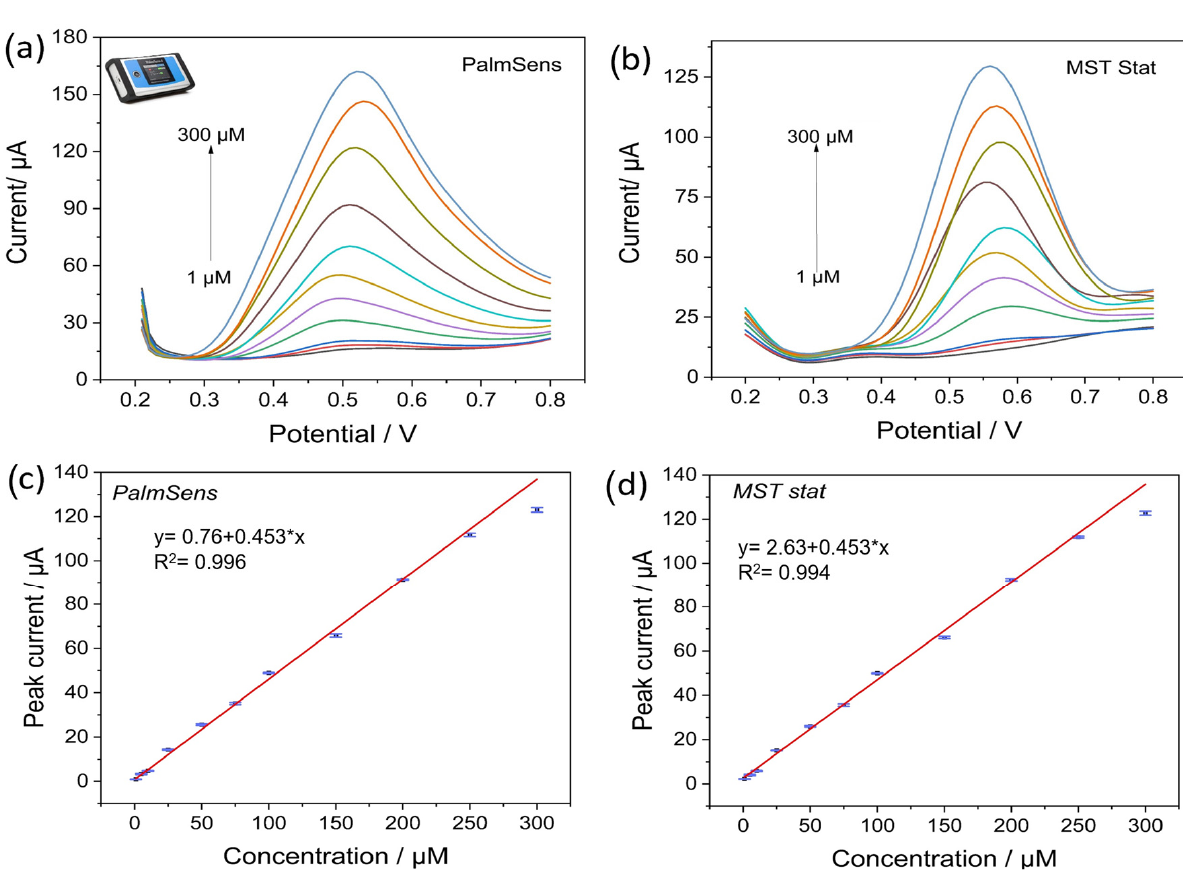
Figure 7. Square wave voltammetric curves at different concentrations for ( a ) PalmSens, ( b ) MSTStat and ( c , d ) the calibration curves with the linear regression equation for PalmSens and MSTStat re- spectively.